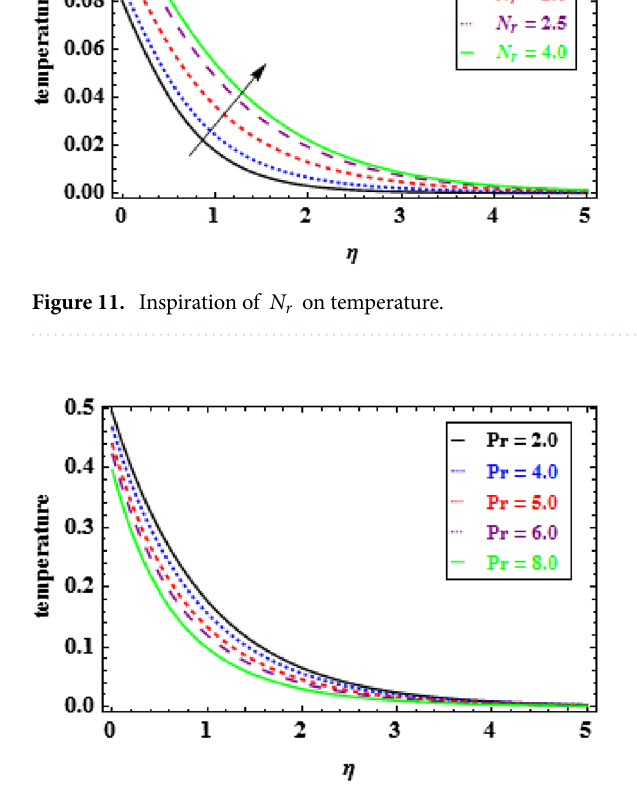
Figure 12. Inspiration of Pr on temperature.